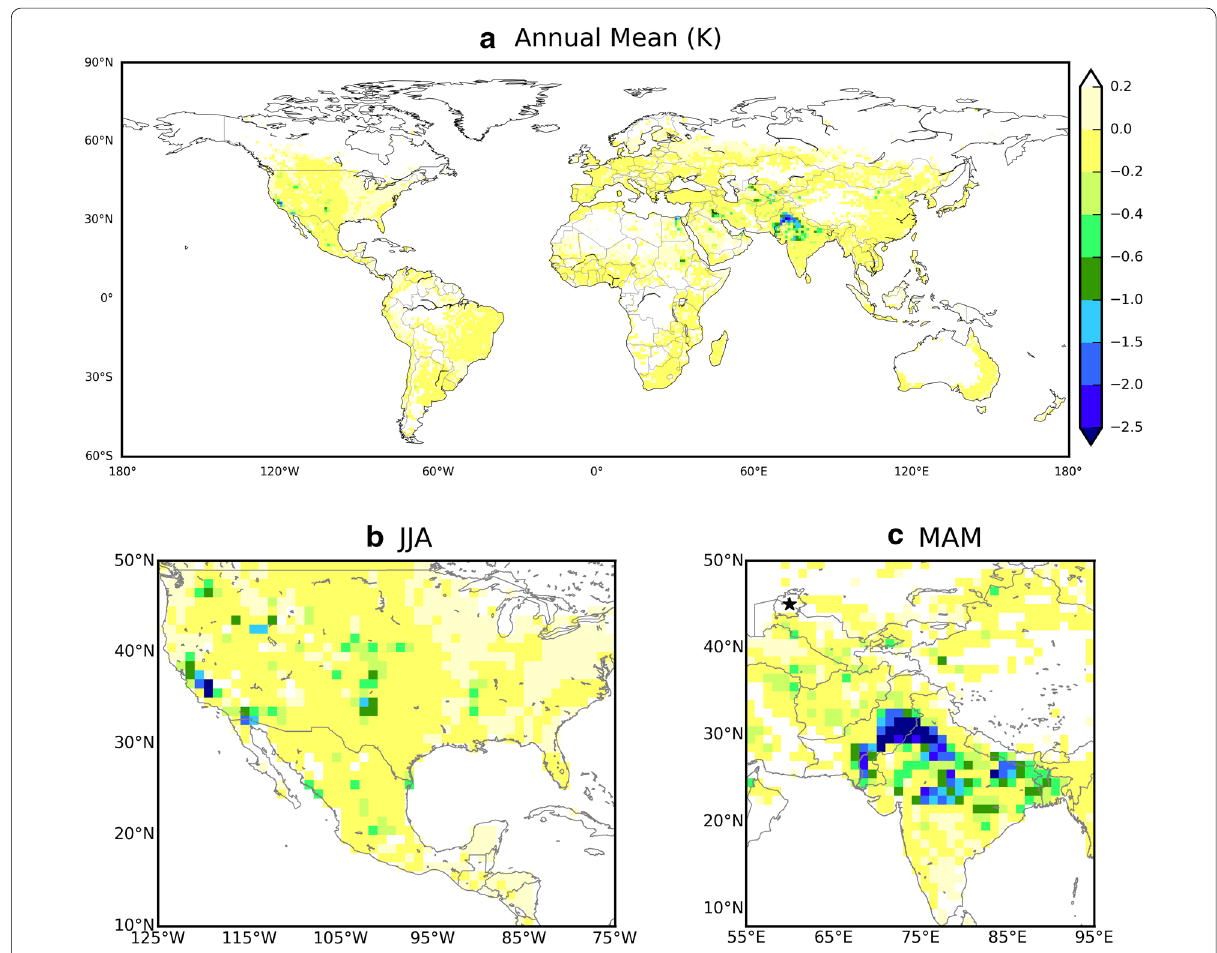
Fig. 4 Changes in grid-averaged annual mean land surface skin temperature due to irrigation ( a ); June–August (JJA) average over the continental US ( b ); and March–May (MAM) mean over the Indian sub-continent and central Asia including the Aral Sea region ( c ). Results shown are the differ- ences between NAT-Offline and HI-Offline simulations. While color represents ocean or land without irrigated areas. The black star in ( c ) locates the Aral